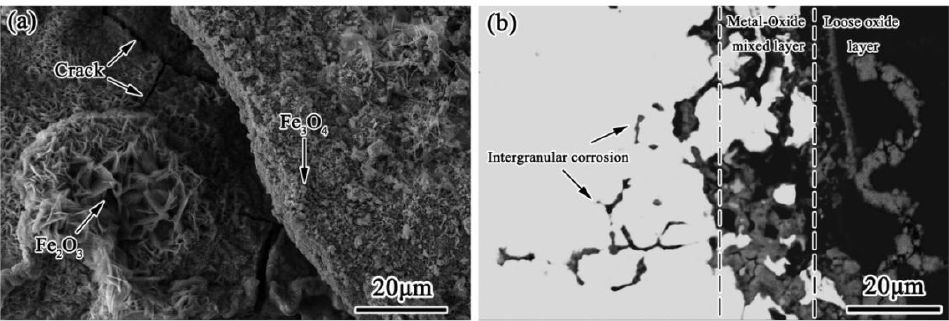
Figure 9. ( a ) Surface image and ( b ) cross-sectional image of the MSS after 100 h hot corrosion at 650 °C.